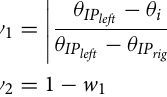
with θ i representing the cylindric angle of the current voxel i and θ IP of the left and right interpolation partners, respectively. The final interpolation of the temperature is done by applying the population map to every slice along the applicator’s main axis using Eq. (2): with T i representing the temperature of the current voxel i and T IP adjacent interpolation partners. To reduce the background noise caused by the air outside of the phantoms, the method from coronal, axial and sagittal view can be seen in Fig.